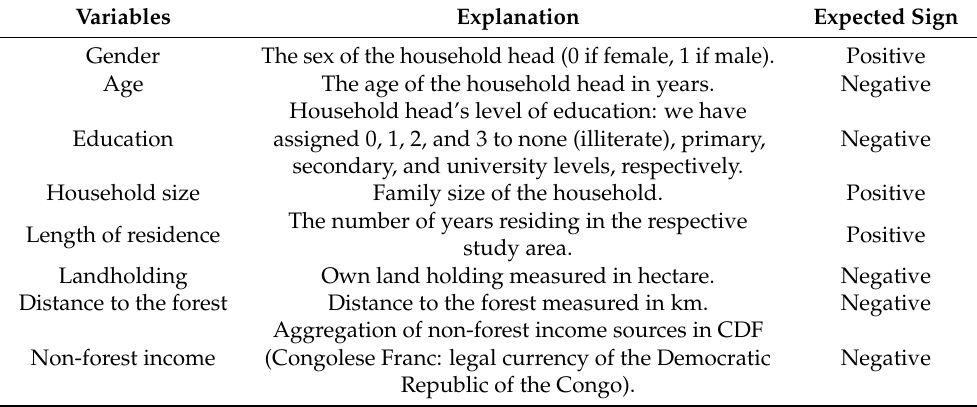
Table 1. Description of the explanatory variables and their expected signs within the forest dependence